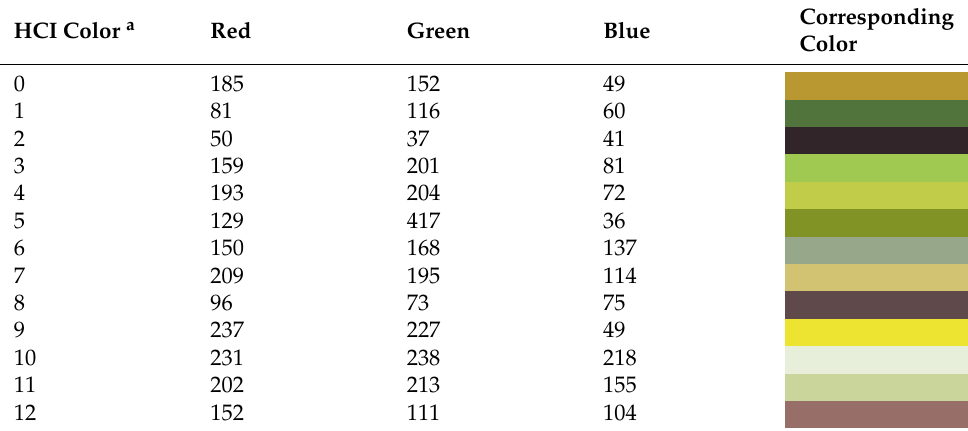
Table 1. Color clusters collected from healthy and symptomatic peanut images that were added to Batch Load Image Processor v.1.1 software as the Hope Color Index for analysis of the images used to develop the diagnostic